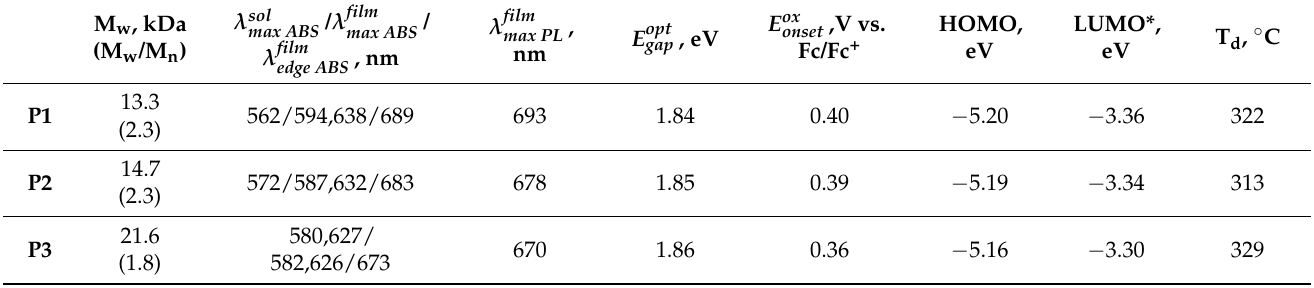
Table 1. Physicochemical, optical, and electrochemical properties of polymers P1 – P3.